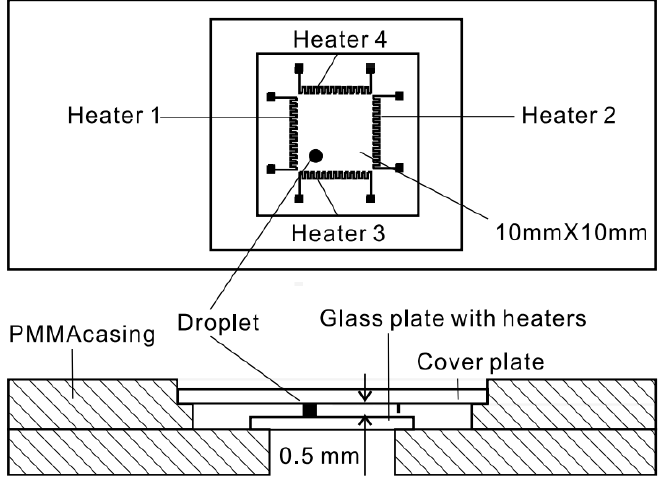
Figure 17. Top and lateral views of the device showing four heaters placed along a square, generating temperature gradients, for which both shape and magnitude influence the heating power of each single heater. Reprinted with permission from [21]. Copyright 2008, Institute of